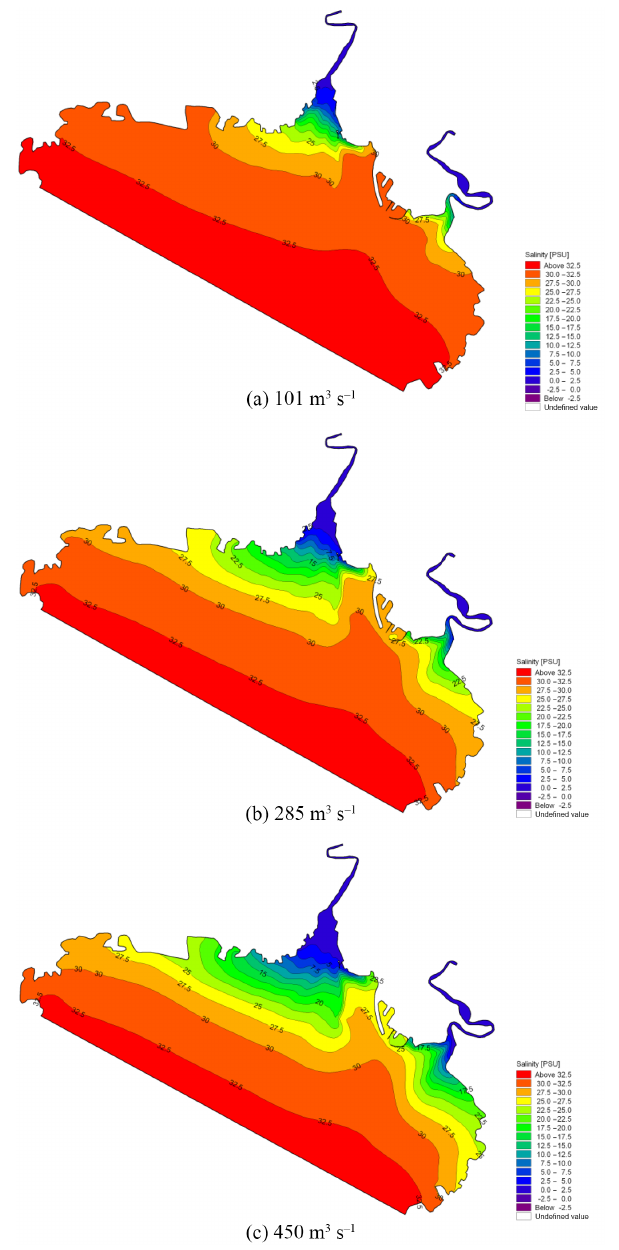
Figure 20. Contour maps of salinity for the period of strongest salt- water intrusion with different rates of